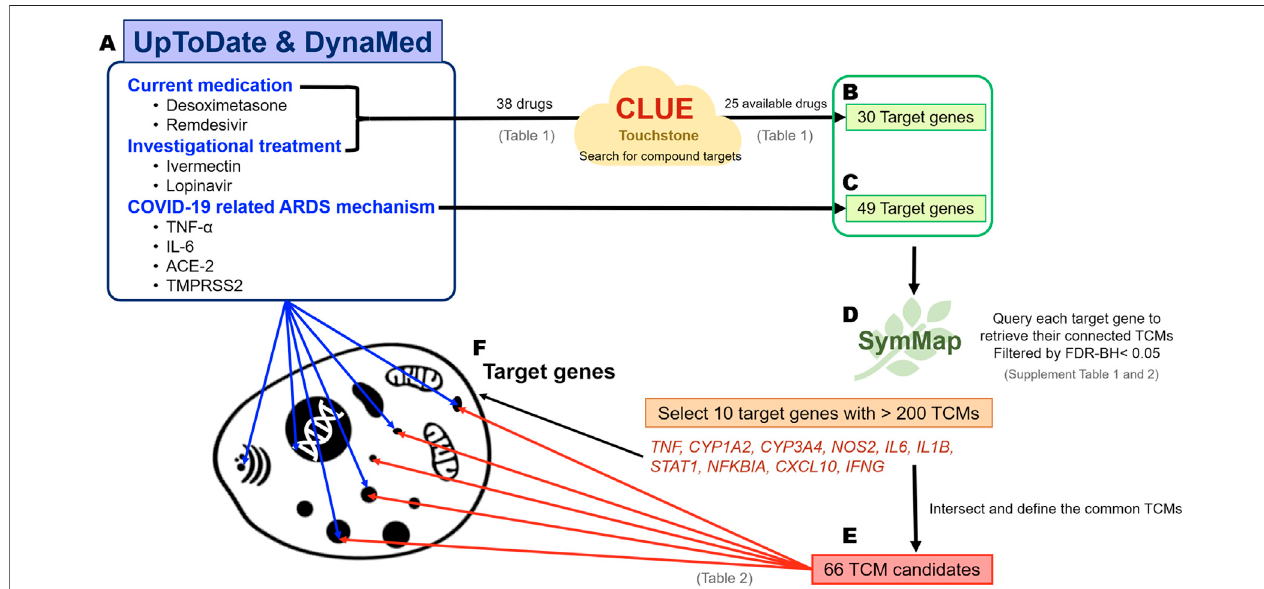
FIGURE1| TheschematicforpredictingTCMcandidatesandthework fl owoftheanalysisoftheirmechanismsofaction.Identi fi cationofpotentialTCMcandidates forCOVID-19treatment.Thetargetgenesindicatethebiologicalfunctionaffectedbythedrugtreatment andviralmechanisms.Therefore,small-molecule reagents,viral mechanisms,andtheTCMcandidatescanbelinkedthroughthecommonsharedtargetgenes.The fl owchartdescribesthestepsinthebioinformaticsanalysis. (A) The 38 well-known small-molecule reagents for COVID-19 treatments were obtained from UpToDate and DynaMed, and 25 out of 38 drugs had the corresponding drug targets via CLUE (TOUCHSTONE). (B) A total of 30 target genes could be obtained from 25 drugs. (C) Forty-nine target genes were identi fi ed by reviewing the COVID-19-related ARDS mechanisms and were included along with the abovementioned 30 target genes for further analysis. Two target genes, TNF and TLR7, were present in both target gene groups. (D) The target above genes were queried separately using SymMap to retrieve their connected TCMs. The ten most frequent target genes were connected to more than 200 TCMs. (E) As a result, 66 TCM candidates shared common connections with all of these 10 target genes. (F) The main goal of our big data analysis was to link the small-molecule agents and TCM via biological target